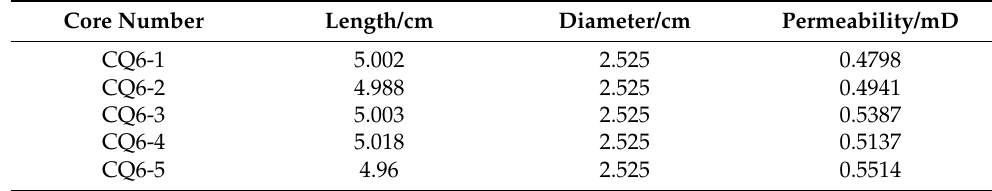
Table 1. Basic physical property data of different sandstone cores.